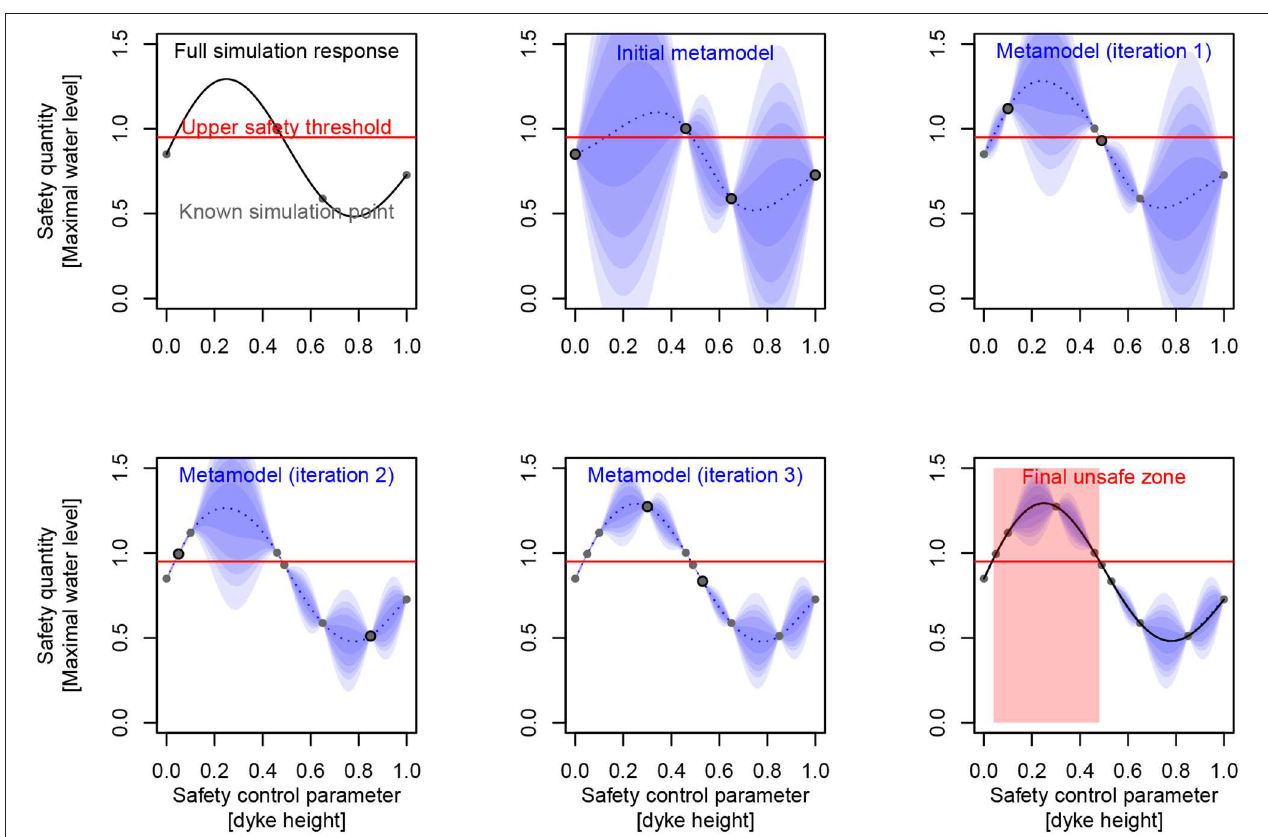
FIGURE 3 | (Left to right, top to bottom) Identification of a safety set on a synthetic case, based on a kriging metamodel iteratively filled/conditioned to reduce set uncertainty (the dots are detailed simulations